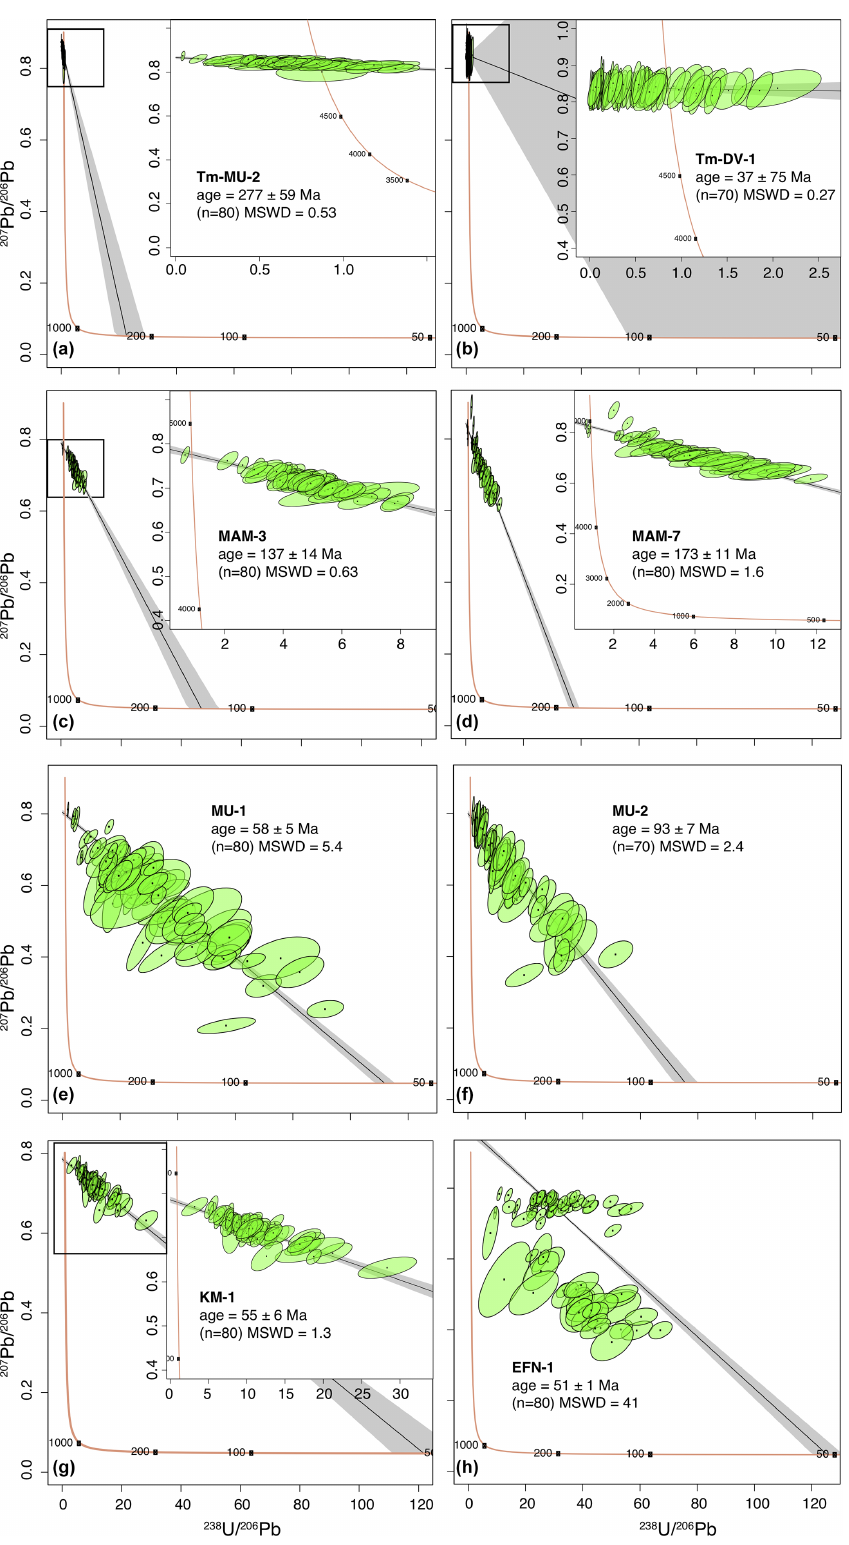
Figure 3. Tera–Wasserburg concordia plots of studied dolomites: syngenetic Cambrian dolomites (a) , hydrothermal dolomites (b) , syn- genetic Cretaceous dolomites (c–d) , early diagenetic dolomites (e–g) , and epigenetic dolomite (h) . All diagrams have similar axes. Isochrons and uncertainties are presented as black lines and gray areas, respectively. Insets show enlargements of ellipse concentration areas. Uncer- tainty ellipsoids of spot analysis are plotted in green and represent 2 σ uncertainties. Geochronology, 3, 337–349,